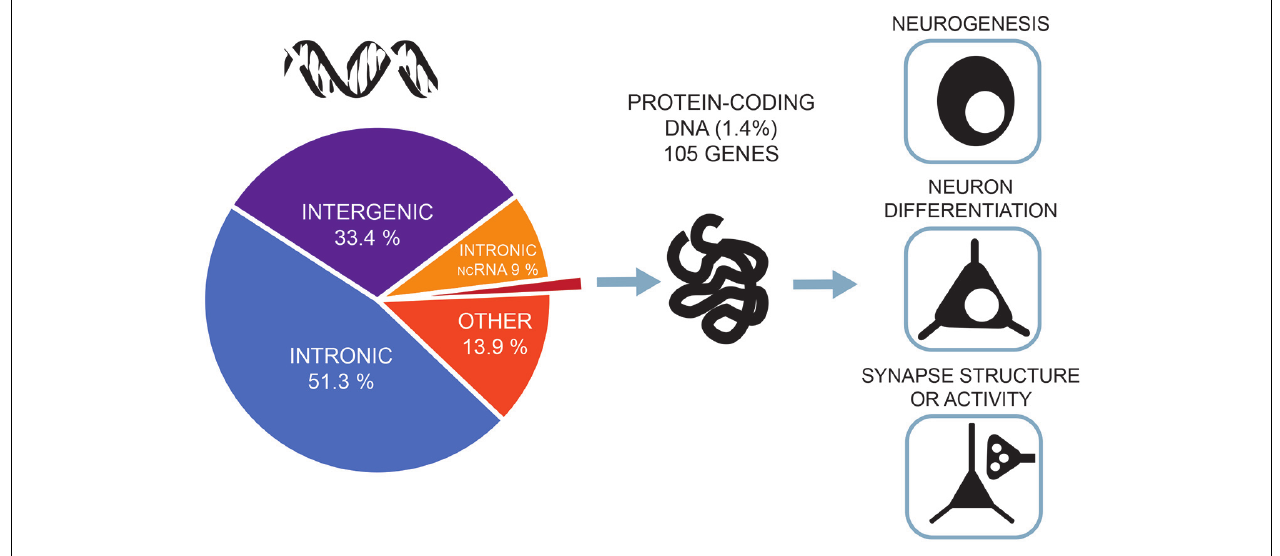
FIGURE 2 | Most of the associated genetic variants of intelligence lie in non-coding DNA regions—only 1.4% of the associated single-nucleotide polymorphisms (SNPs) are exonic, non-synonymous variants and lie in protein-coding genes. Gene-set analyses implicate pathways related to neurogenesis, neuron differentiation and synaptic structure. The figure is based on the results from the most recent and largest genome-wide association studies (GWAS) of intelligence by Savage et al.